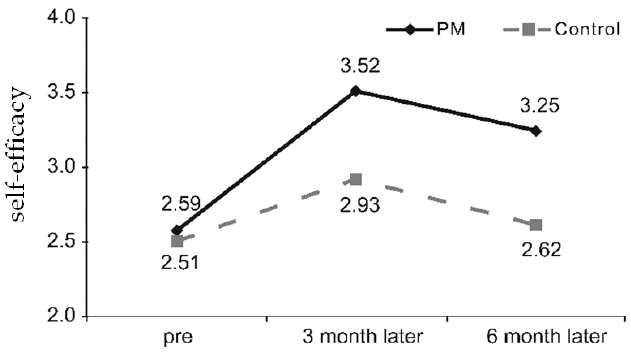
Figure 3. Differences in self-efficacy behavior according to education groups. PM, pattern Figure 3. Di ff erences in self-e ffi cacy behavior according to education groups. PM, pattern management. management.